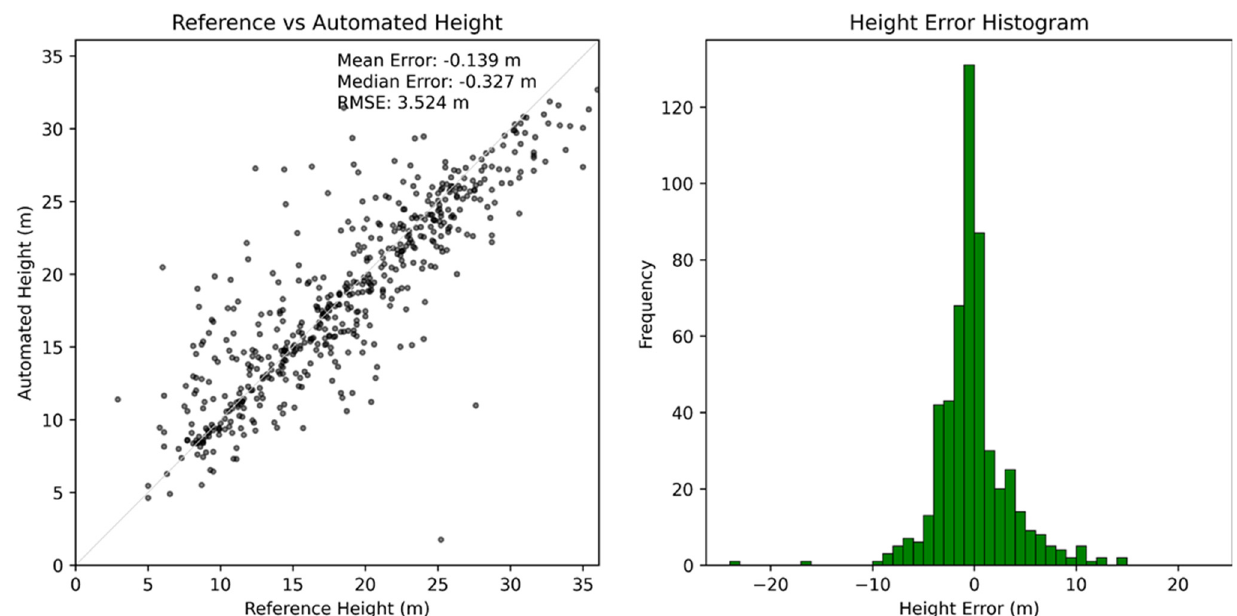
Figure 12. Left shows a scatter plot of the automatically measured tree height compared with the reference tree height. The grey line shows what a perfect result would be (y = x). Right shows the distribution of the height errors.